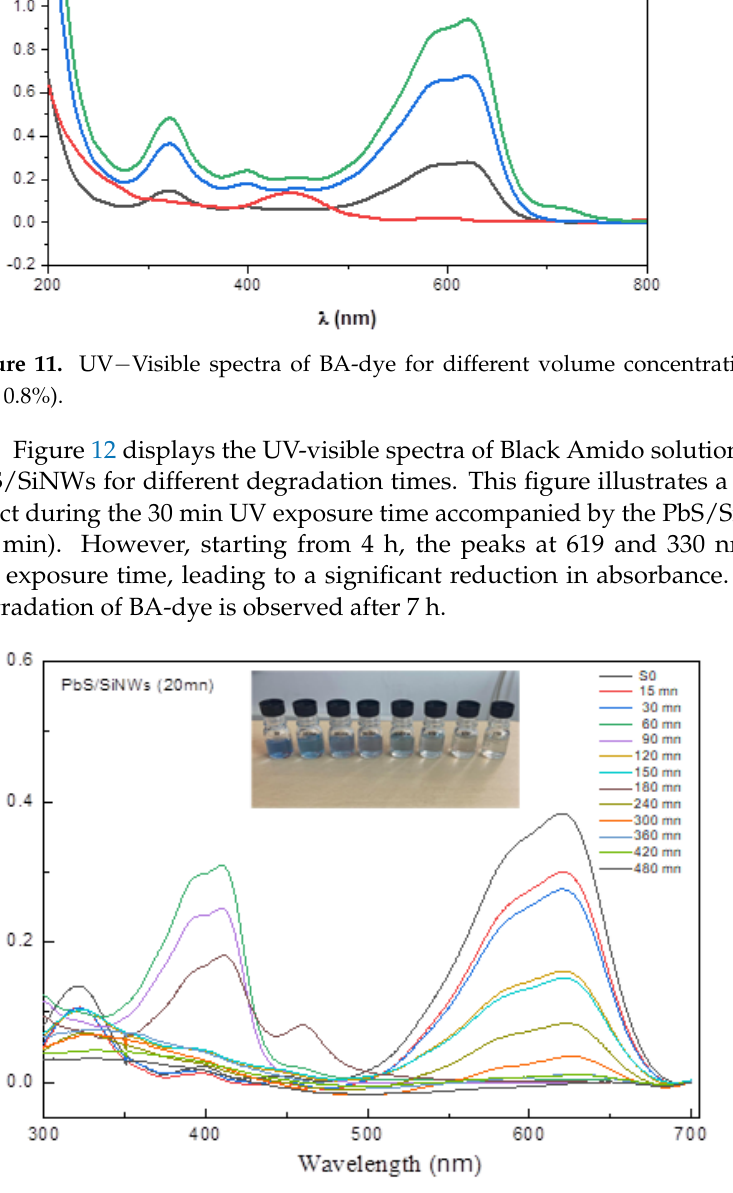
Figure 12. UV − visible spectra of BA-dye of volume concentration 0.4% in the presence of PbS/SiNWs nanohybrids (20 min) as a catalyst.